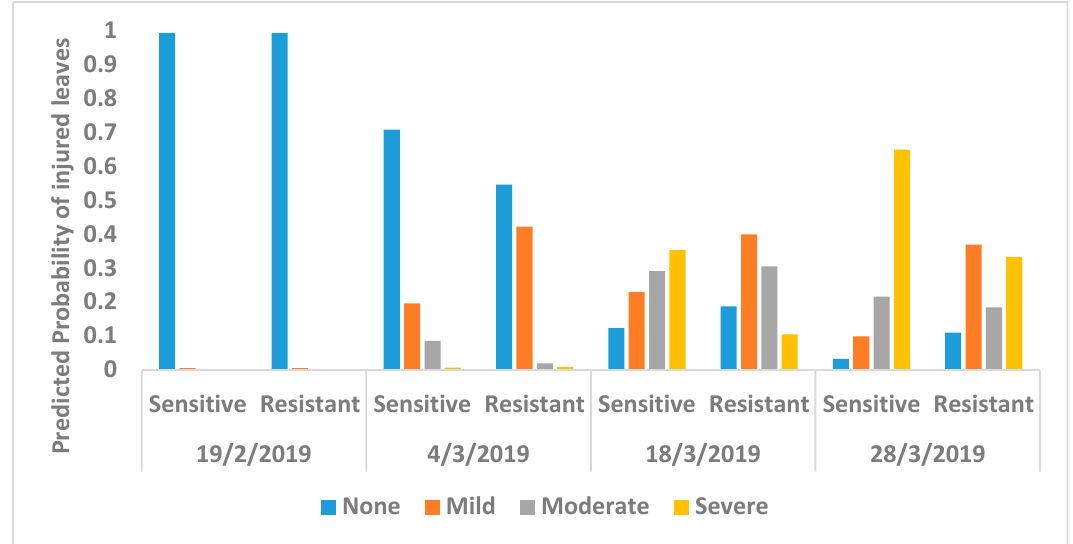
Figure 4. Predicted probability of O 3 -induced visible foliar injury according to the injury index from growing stage to harvest for resistant and sensitive genotype of Phaseolus vulgaris calculated using multinominal logistic regression model. None is no O 3 injury, mild is < 5% injury, moderate is 5% to 25% injury, and severe is > 25%